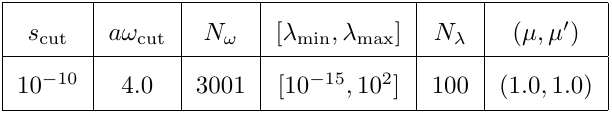
operator at several 12